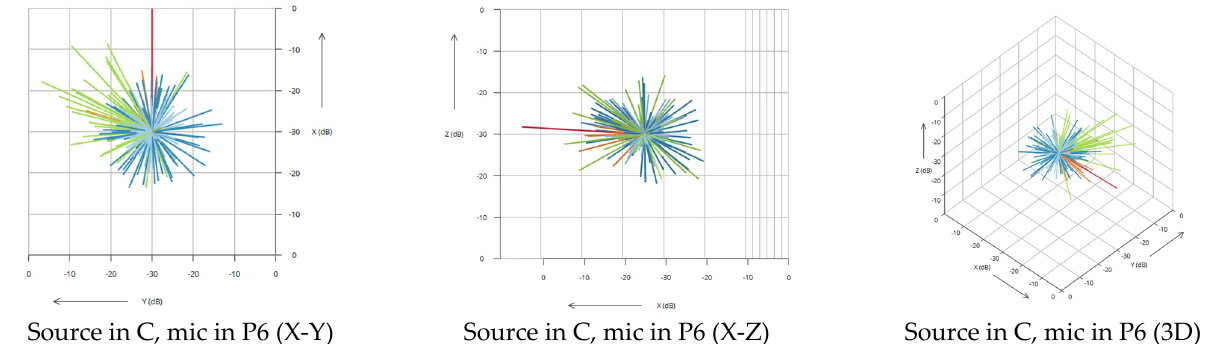
Figure 14. DOA of reflections. Source in C, microphone in P6. 30 dB range. There are two groups of strong reflections with delays around 30 and 50 ms. IRIS shows they both come from the left side (Figure 15). The source was positioned in C (red dot and line), while the first group came from the parapet (green lines and dot, 15–50 ms delayed) and the second from the outer ring (blue lines and dot, >50 ms delay). The delays match the length of the geometrical paths.